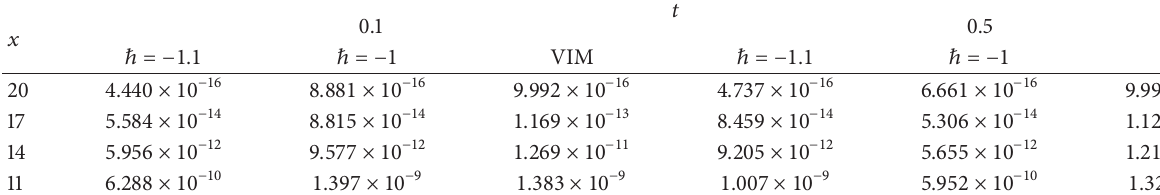
Table 3: Absolute errors of 𝜙(𝑥,𝑦,𝑡)